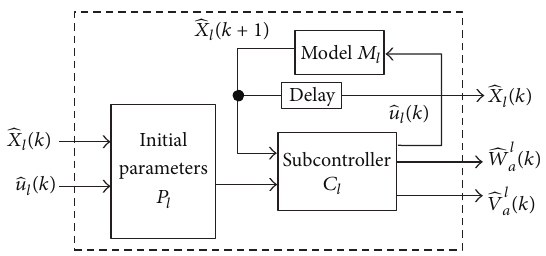
Figure2:StructureofmultiplemodelADPwithestimatedsubmod-